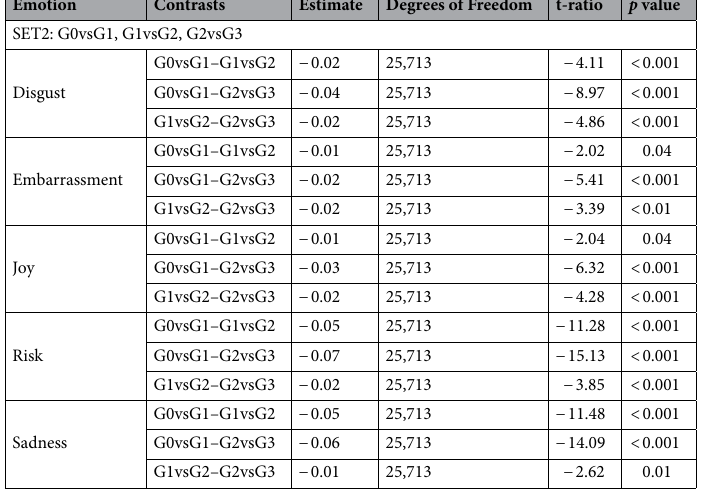
Table 2. Summary of follow-up tests statistics for cosine similarity (CS) mean differences between emotions and within generation contrasts from SET2.